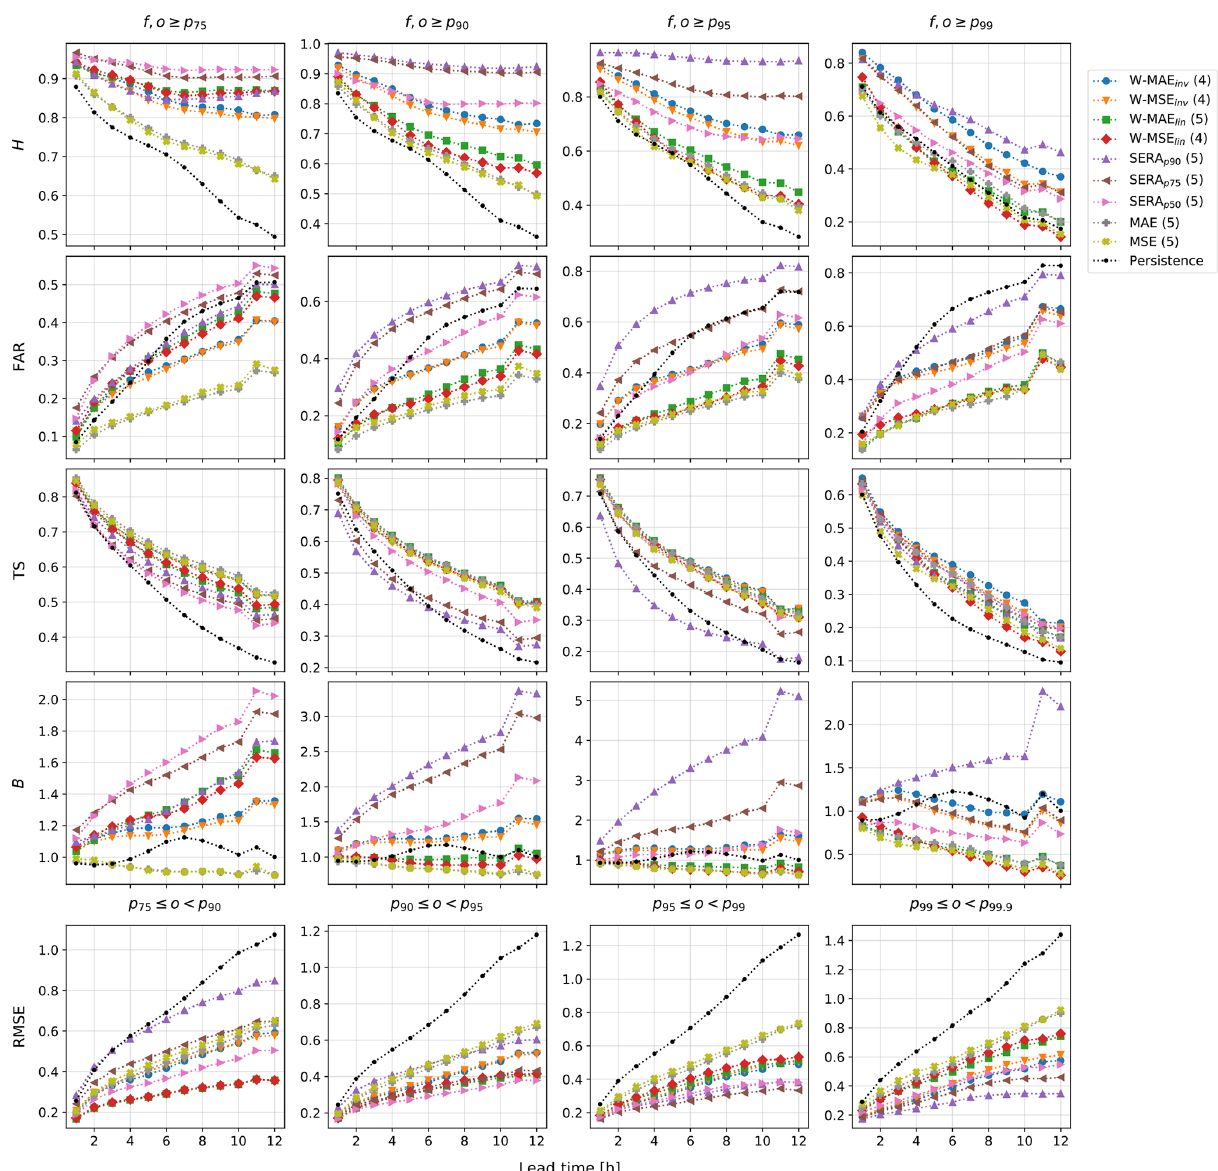
Figure 6. Comparison of the hit score ( H ), false alarm ratio (FAR), threat score (TS), frequency bias ( B ) and root-mean-squared error (RMSE) of the ConvLSTM network trained with each different loss function, plotted over lead time (in hours) and various percentile intensity thresholds. The optimal number of network layers used for each loss function is given in brackets after the name of the loss function. The label “persistence” refers to the persistence